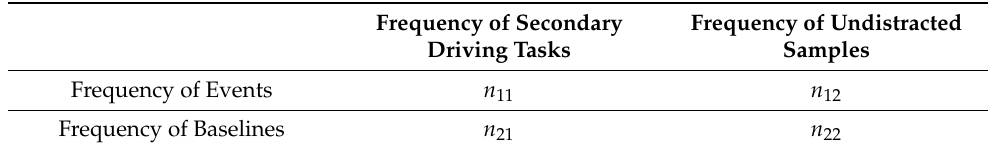
Table 3. Frequency of one secondary driving task and undistracted samples under events and baselines.